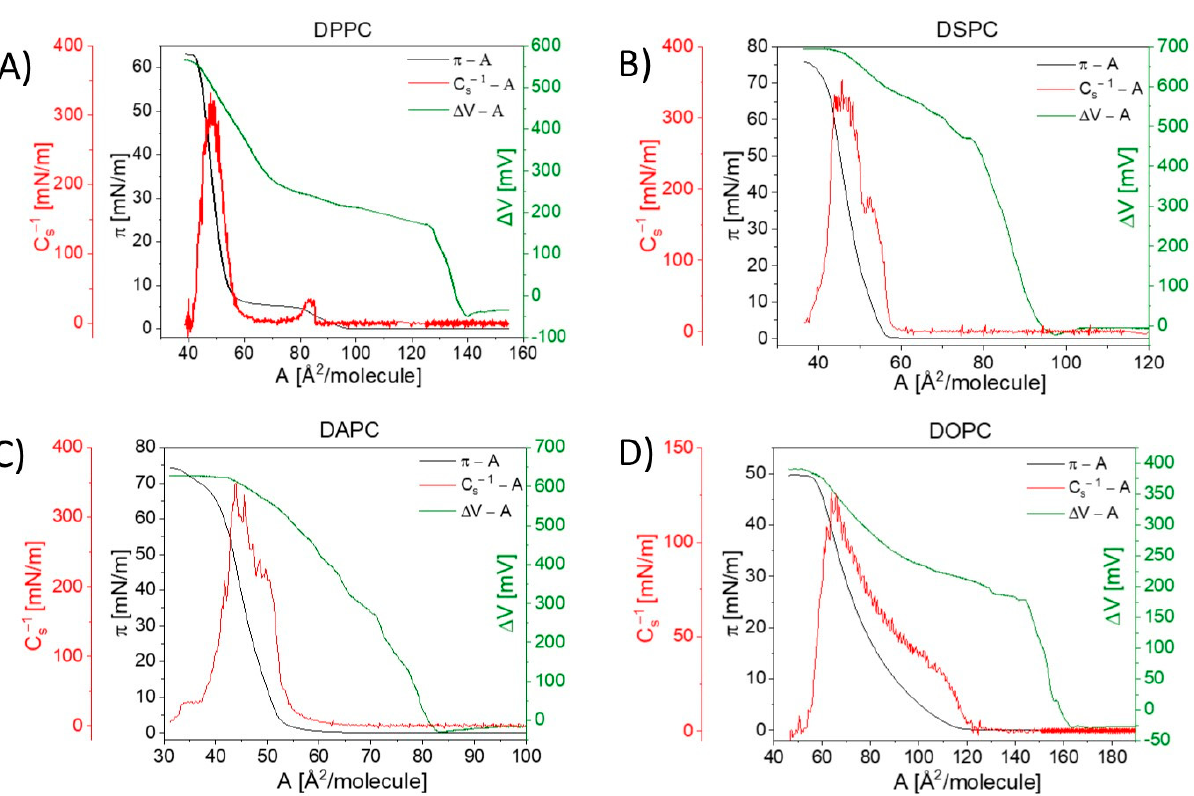
Figure 2. Electric surface potential change and surface pressure isotherms, together with calculated compressional moduli curves for selected phosphatidylcholines: ( A ) DPPC (1,2-dipalmitoyl-sn-glycero-3-phosphocholine), ( B ) DSPC (1,2-distearoyl-sn-glycero-3-phosphocholine), ( C ) DAPC (1,2-diarachidoyl-sn-glycero-3-phosphocholine) and ( D ) DOPC (1,2-dioleoyl-sn-glycero-3-phosphocholine).